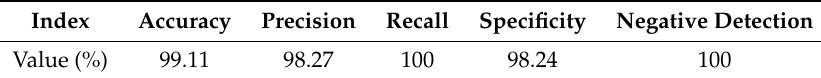
Table 17. Detection evaluation indices.